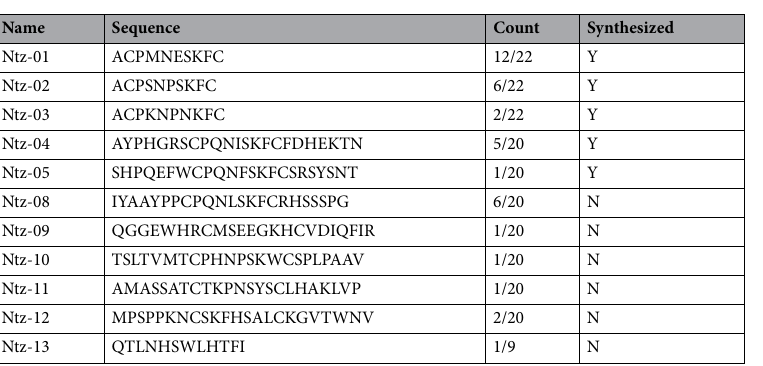
Table 2. Selected sequences. Biopanning-selected sequences that were confirmed positive by phage clone binding of natalizumab. The total Count (denominator) includes candidates that were negative by phage clone binding (sequences not shown). All peptides were synthesized with C -terminal